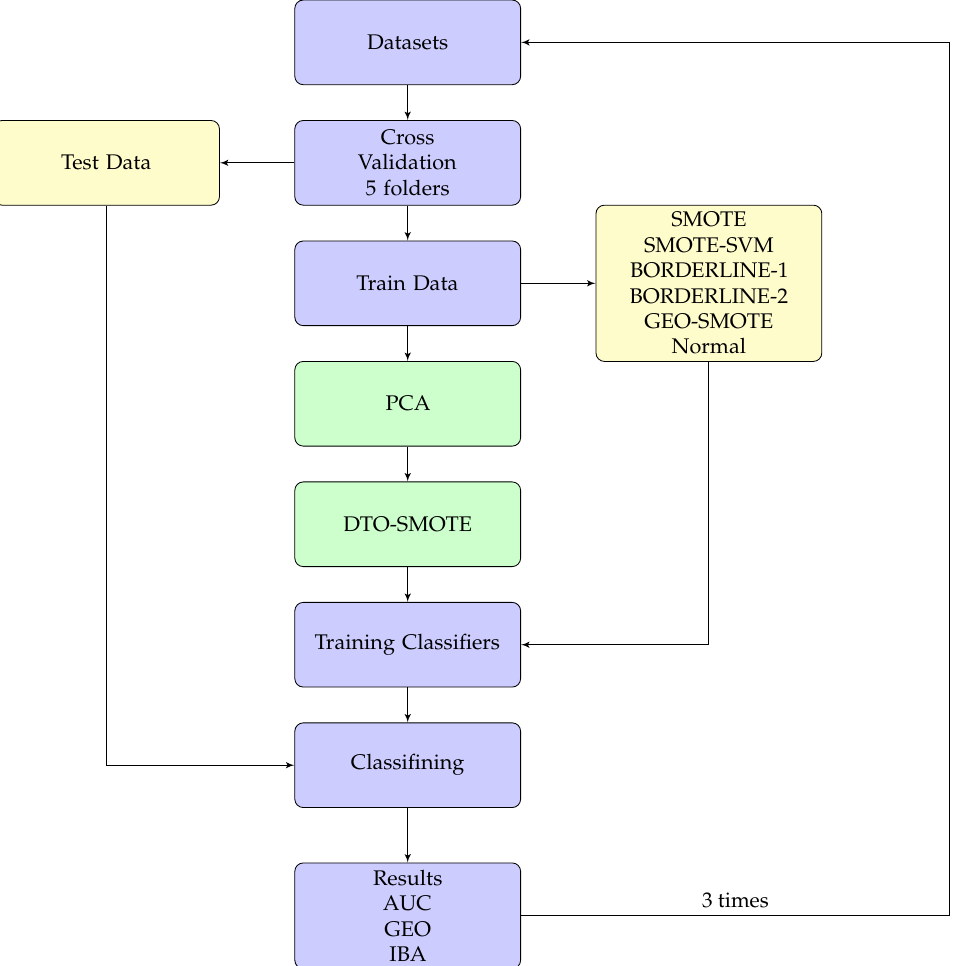
Figure 4. Delaunay Tessellation Oversampling Synthetic Minority Over-sampling Technique (DTO-SMOTE)